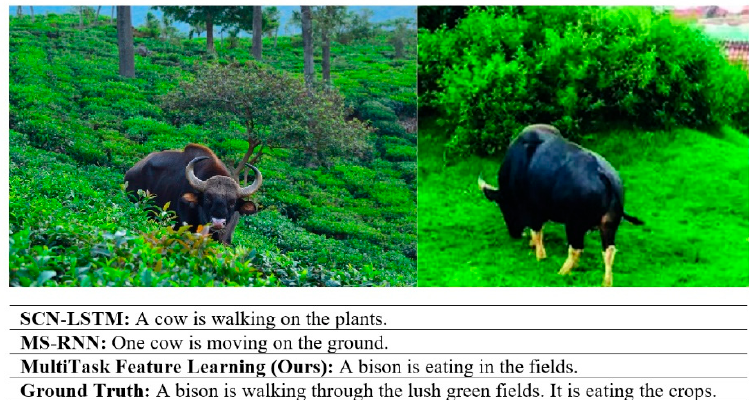
Figure 4. Intrusion video.